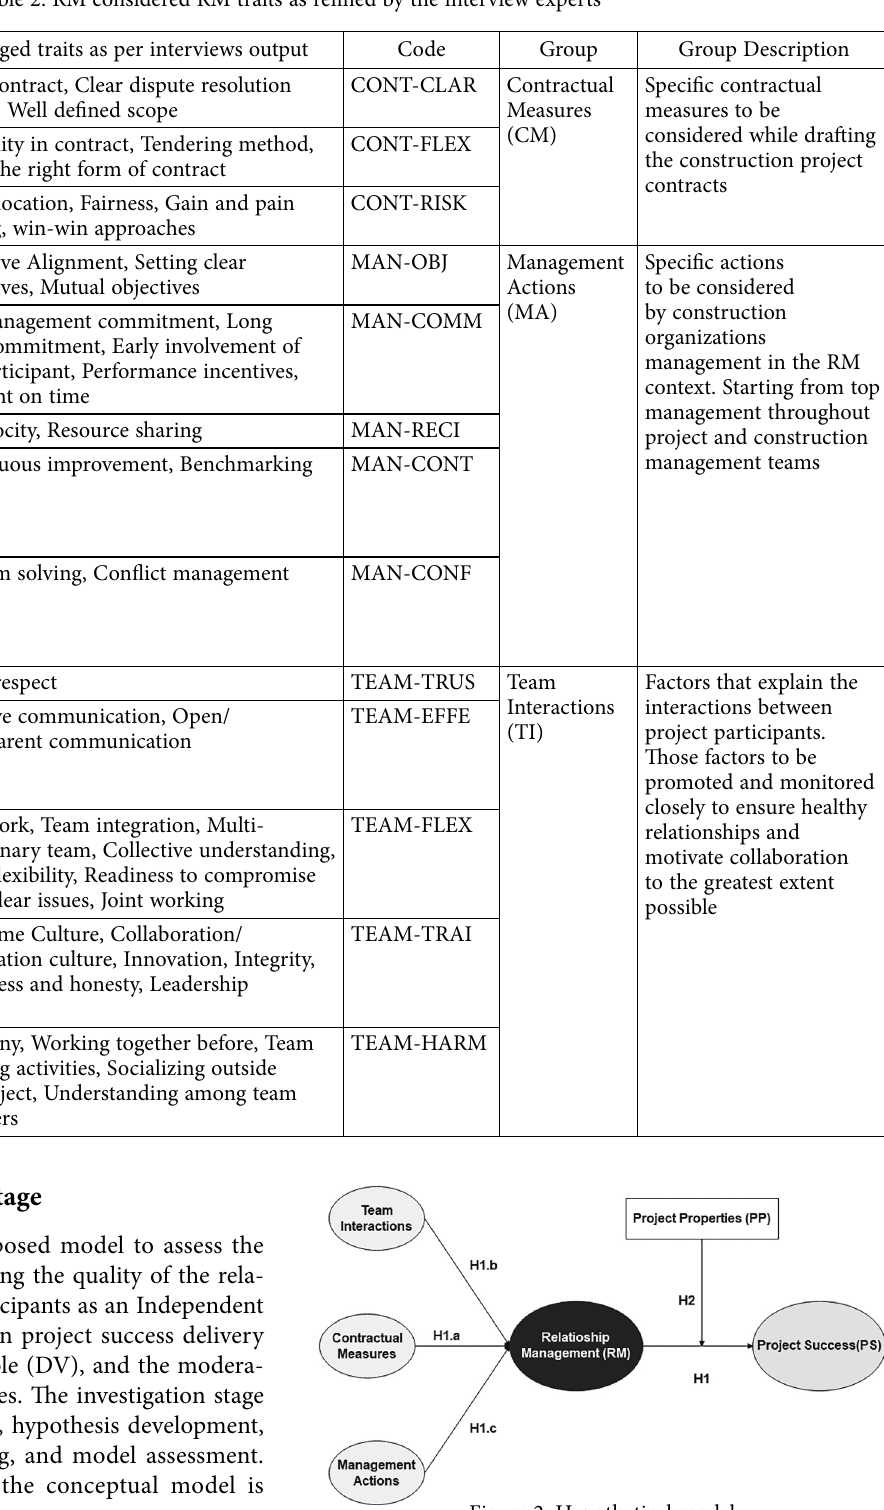
Table 2. RM considered RM traits as refined by the interview experts